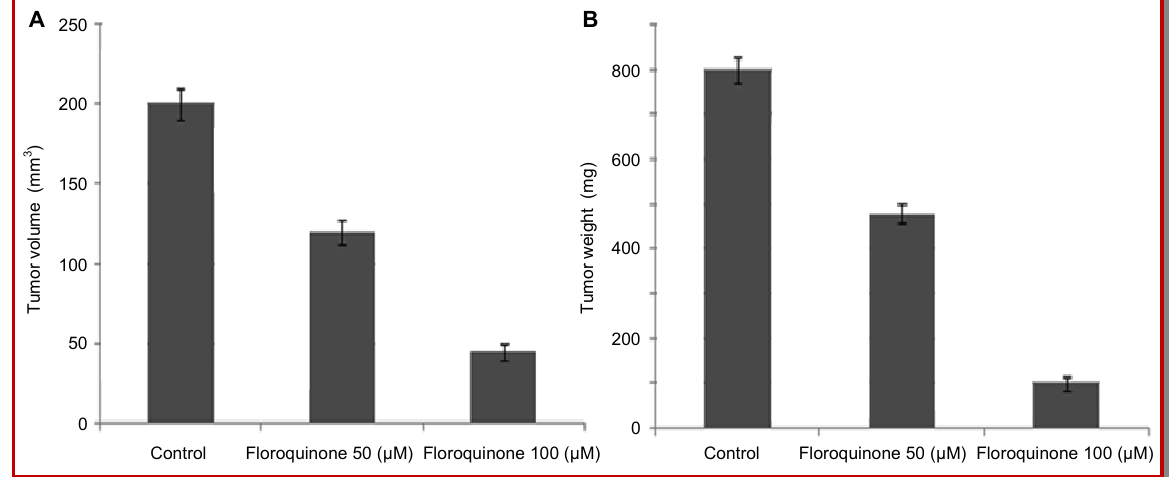
Figure 5: Floroquinone treatment inhibits tumor growth in vivo in the mouse xenograft model. HOTHC cells were administered in the mouse followed by treatment with 50 and 100 mg/kg doses of floroquinone for one month alternatively. After one month the mouse were sacrificed to extract the tumor for determination of (A) tumor volume and (B) tumor